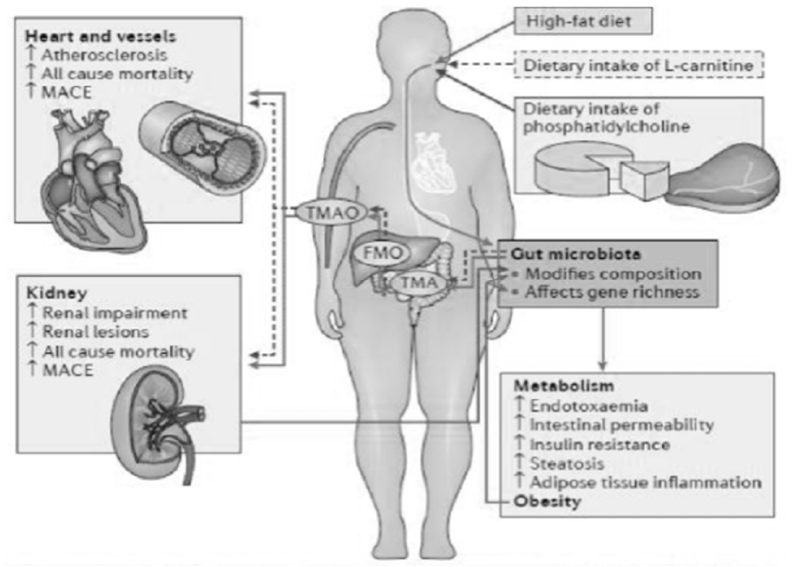
Figure 4. Toward the comprehensive understanding of the gut ecosystem via metabolomics-based integrated omics approach, Wanping et al., Semin Immunopathol 2014.